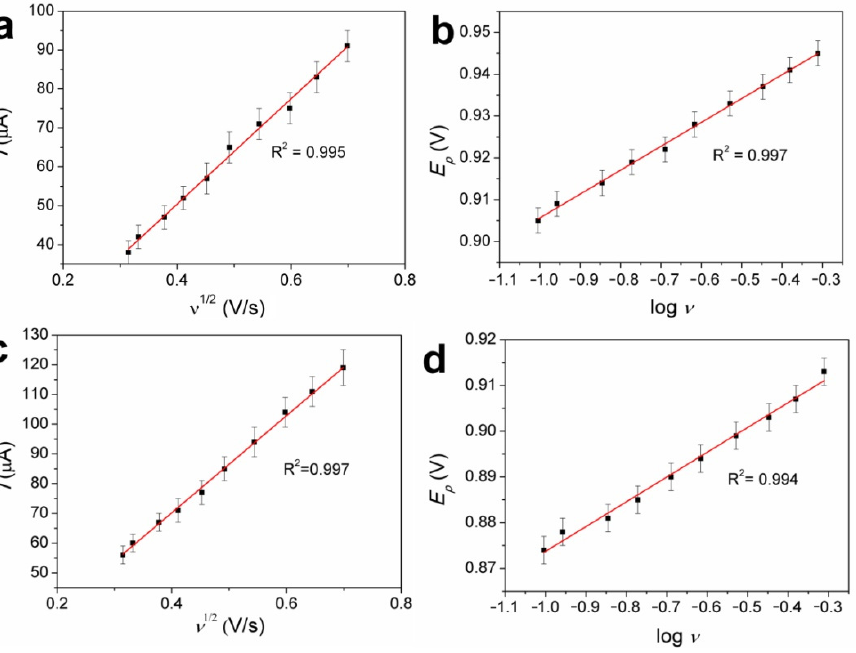
Figure 5. I - υ 1/2 and E -log υ dependences for the FePc(tBu) 4 /GCE ( a , b ) and Au/FePc(tBu) 4 /GCE ( c , d ). Table 2. I - υ 1/2 and E-log υ dependences for the FePc(tBu) 4 /GCE and Au/FePc(tBu) 4 /GCE.